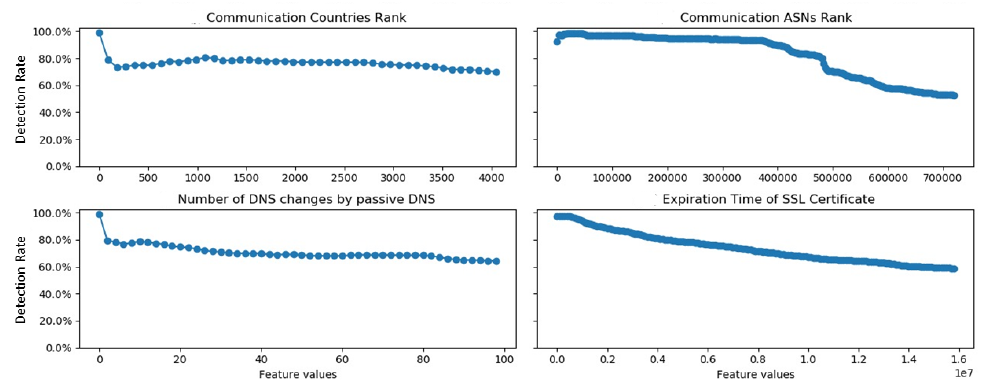
Figure 6. Novel robust feature manipulation